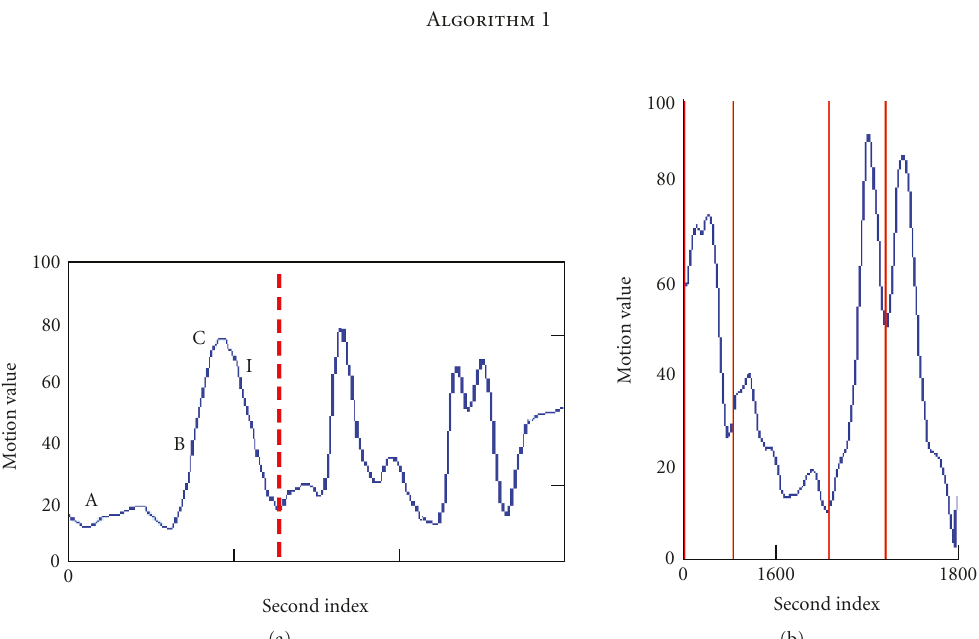
Figure 4: (a) Significant event segment consisting of the motion pattern, (b) criterion for reserving or dropping segments based on IVal : 1st dropped, 2nd dropped, 3rd reserved, and 4th